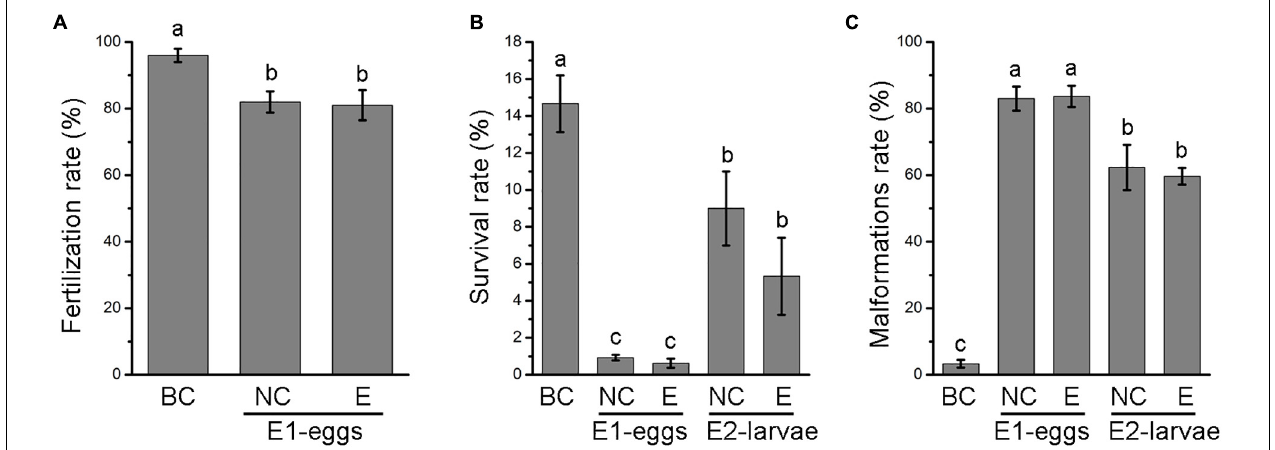
FIGURE 2 | Fertilization rate (A) , survival rate (B) and malformations rate (C) of oyster larvae after electroporation. BC, black control; NC, negative control; E, electroporation group. Error bars represent means ± SD of three independent repeats. One-way ANOVA were used for significance analysis ( P < 0.05).